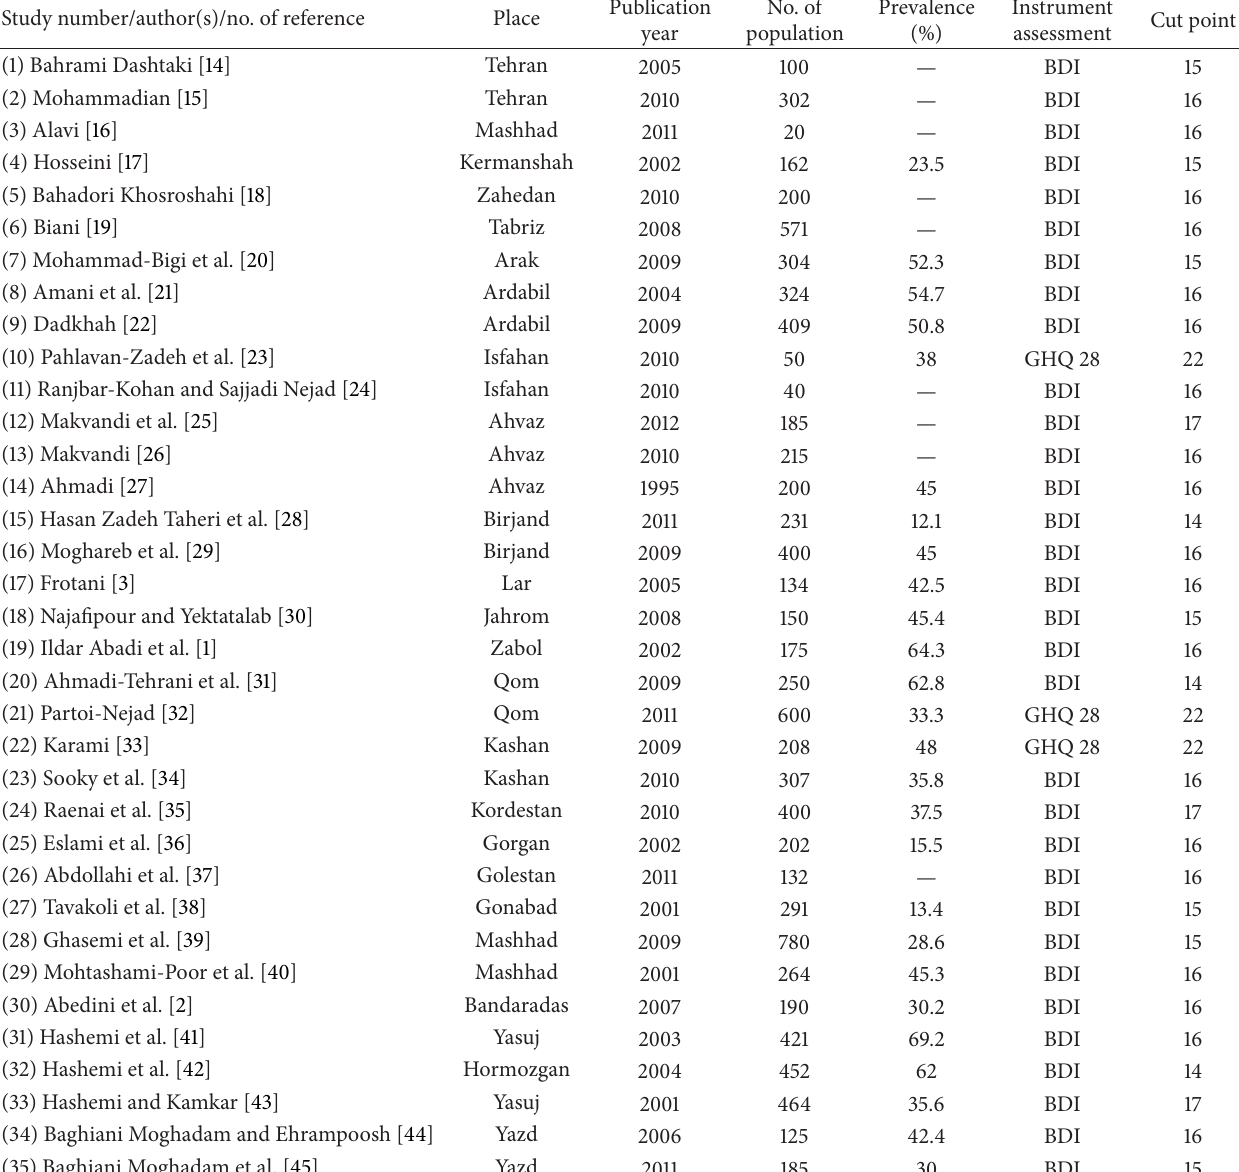
Table 1: Feature and characteristic studies included in